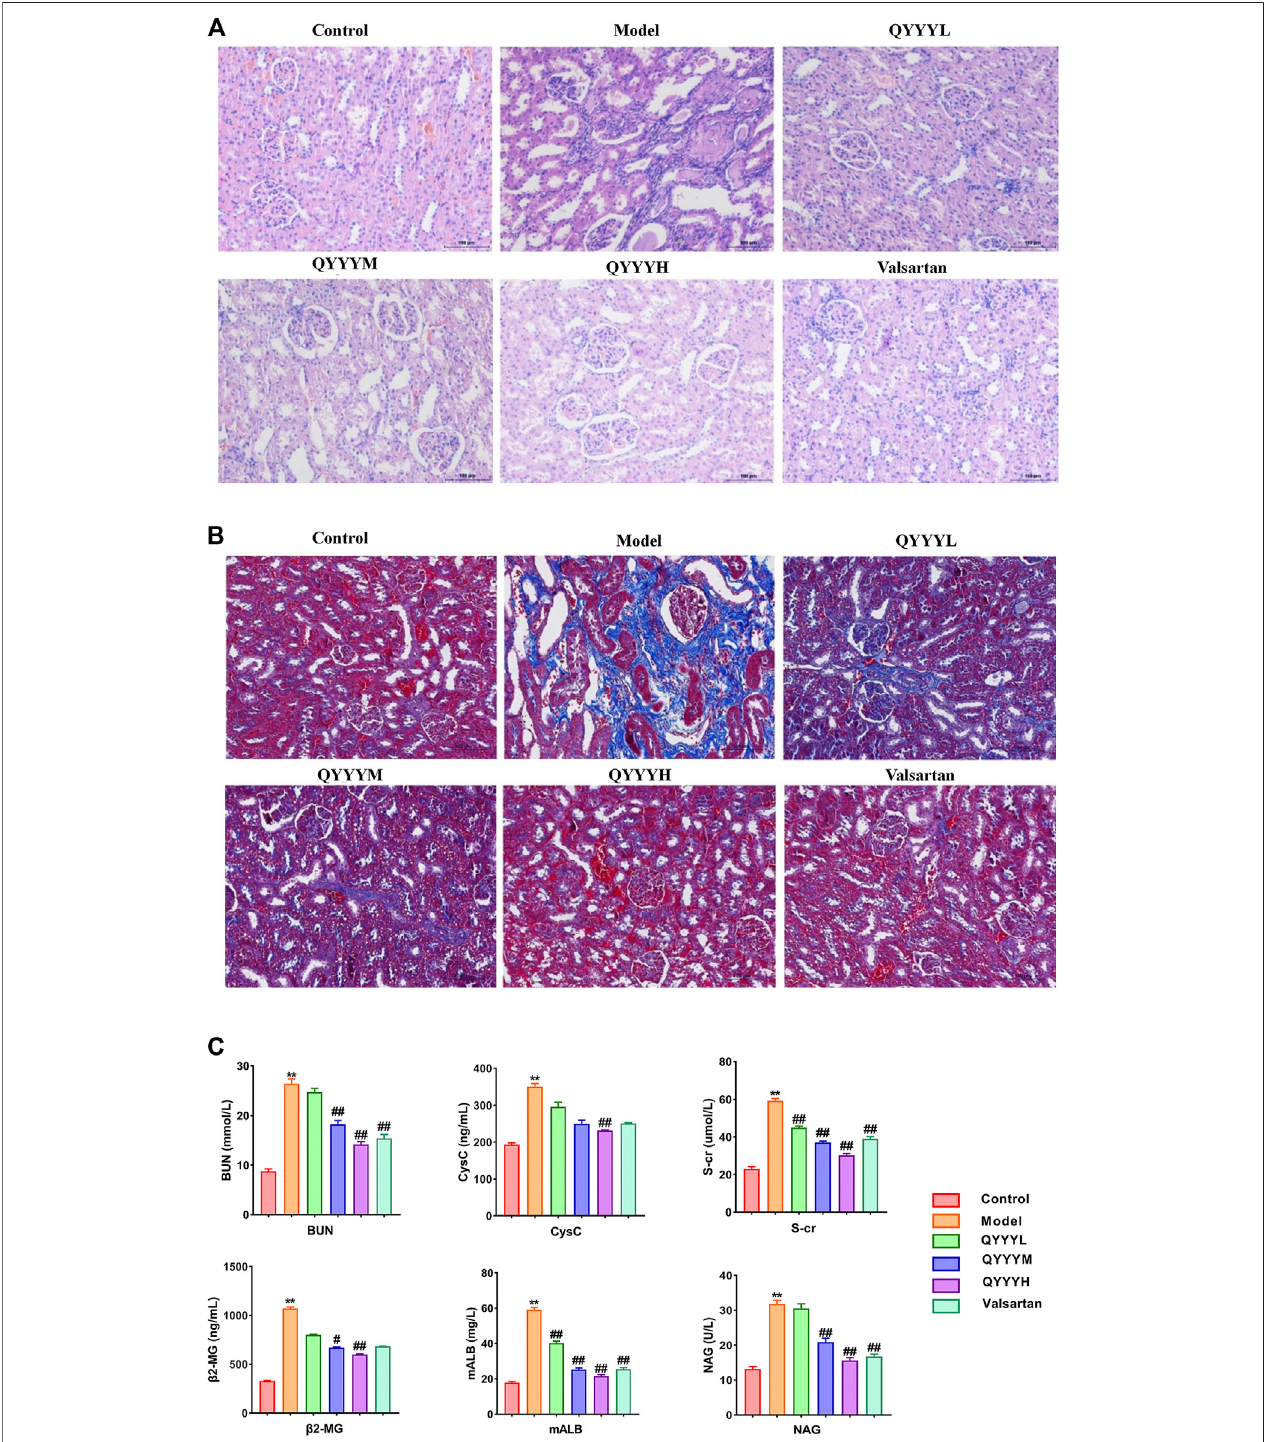
FIGURE1| QYYYpromotedpathology, fi brosisandrenalfunction invivo .SHRwererandomlydividedinto fi vegroups:Modelgroup,QYYYL(lowdose3.2 g/kg/d), QYYYM(middledose6.4 g/kg/d),QYYYH(highdose12.8 g/kg/d)groupandvalsartangroup(17 mg/kg/d).WKYofthesameagewereusedasthecontrolgroup.WKY werefedwithnormalsaltdiet(0.4%NaCl)whileSHRwerefedwithhighsaltdiet(4%NaCl)for8 weekstoestablishhypertensivenephropathymodelandthenbetreated withQYYYorvalsartanforanother8 weeks. (A) EffectsofQYYYonrenalhistomorphologyinrats. (B) EffectsofQYYYonmassonstainingmethodforstainingrenal fi brosis. (C) Effects of QYYY on renal function in SHR. * p < 0.05 and ** p < 0.01 as compared with the control group. # p < 0.05 and ## p < 0.01 as compared with the model group.